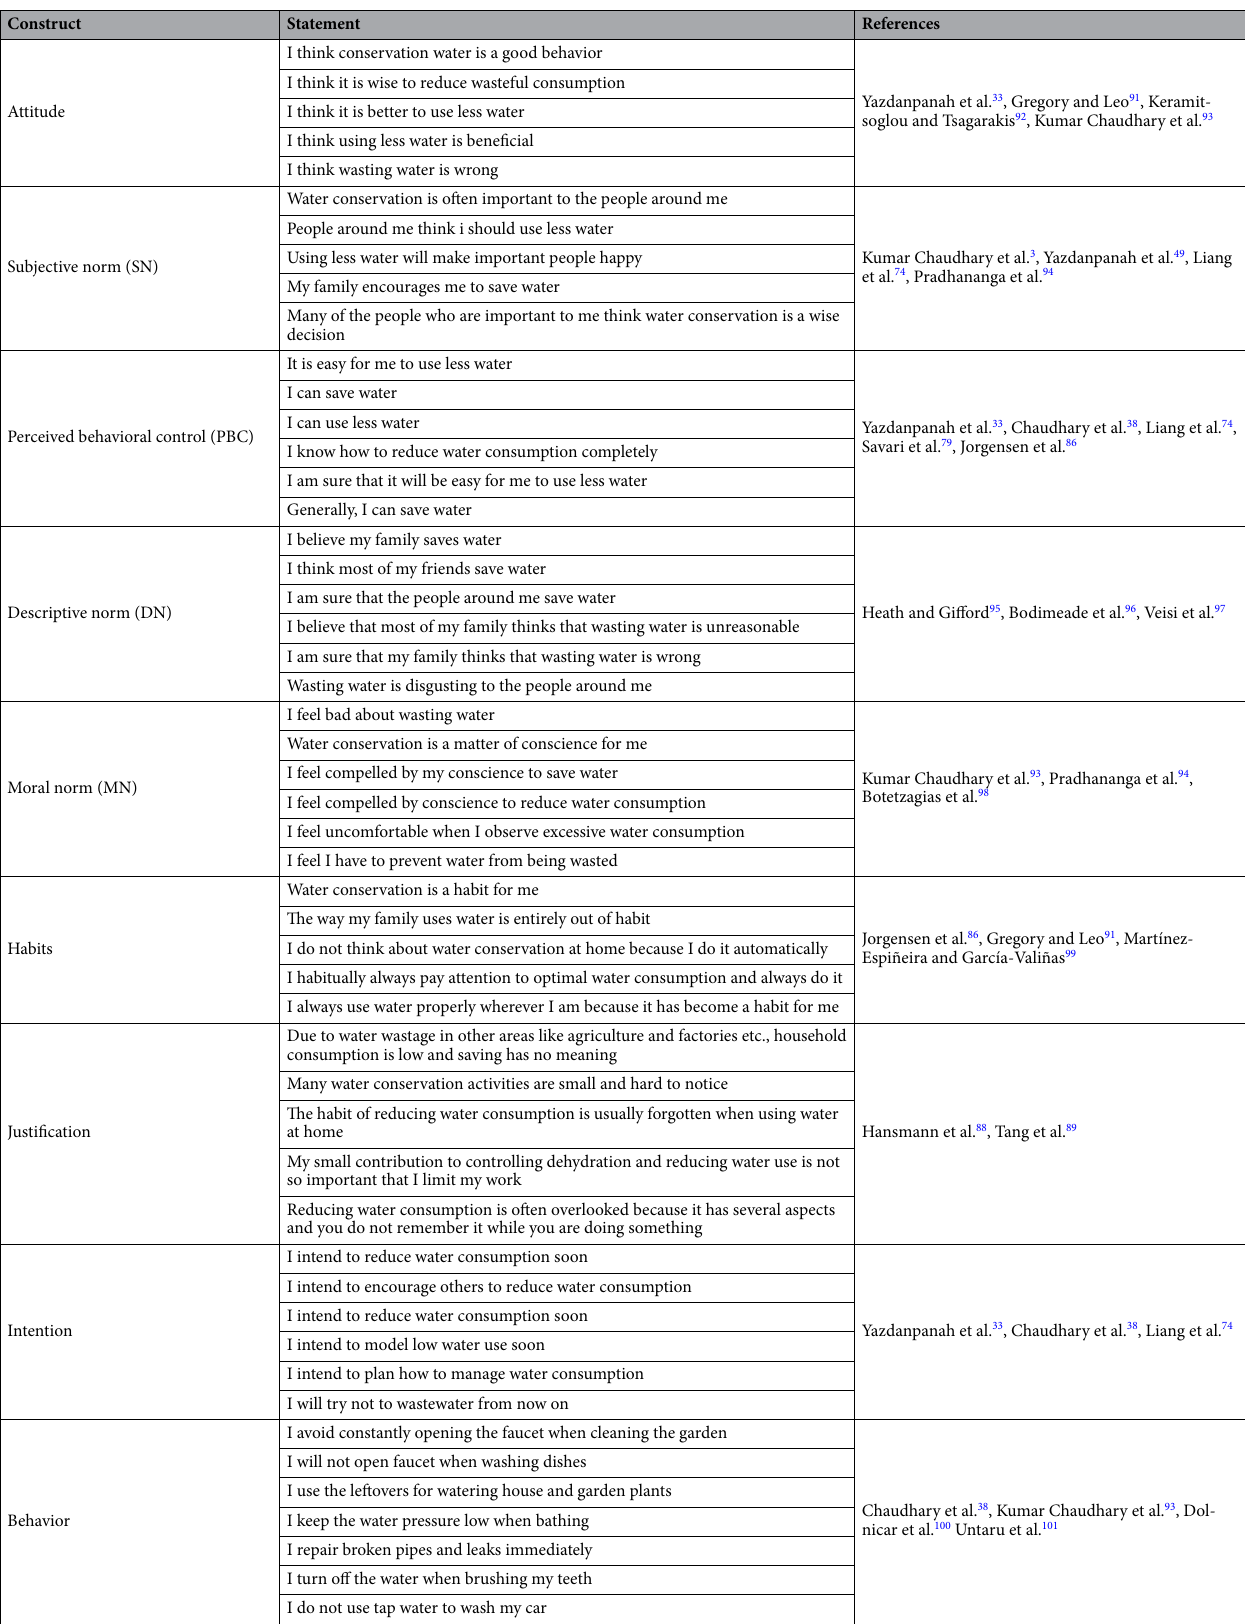
Table 1. Survey items and relevant